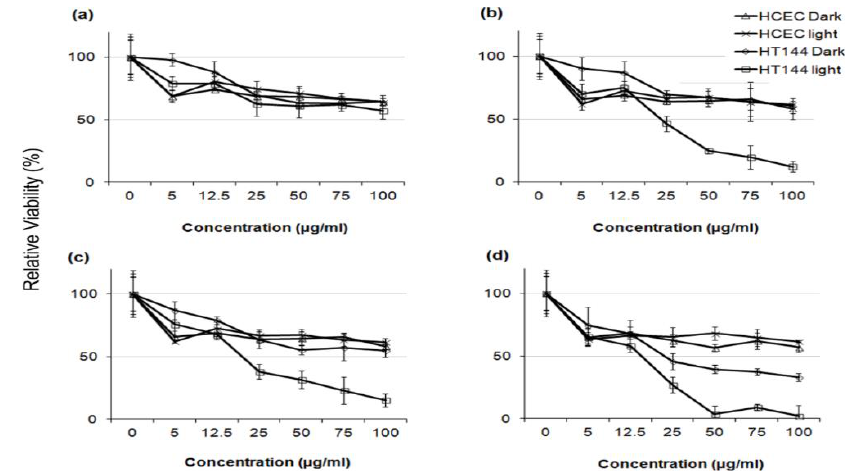
Figure 35. Cell viability of HCEC and HT 144 cells treated with ( a ) ZnO, ( b ) ZnO:Ag(10%), ( c ) ZnO:Ag(20%) and ( d ) ZnO:Ag(30%) of different concentrations (5, 12.5, 25, 50, 75, 100 μg/mL) under visible light and dark conditions. Data are presented as mean ± standard deviation of two independent experiments with triplicates of each sample. Reproduced from [175] under the terms of the Creative Commons Attribution license.